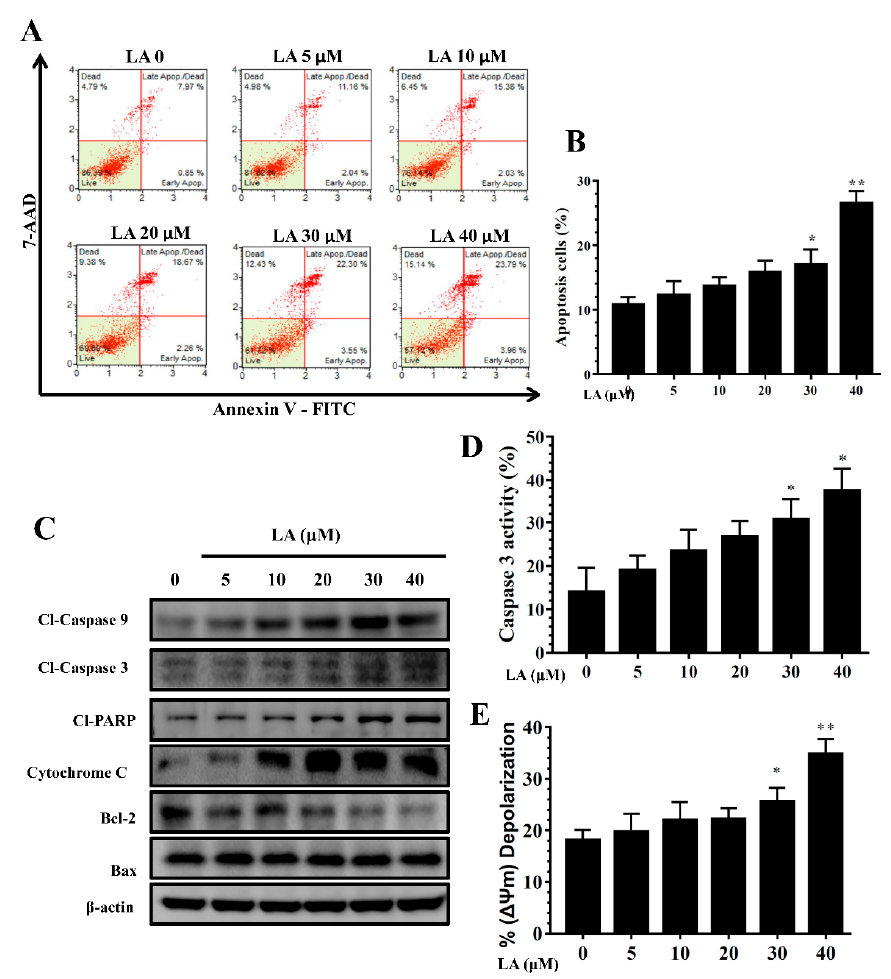
Figure 6. Licochalcone A (LA) regulated apoptosis in MDA-MB-231 cells. ( A ) Flow cytometry results showing that 24-h treatment with licochalcone A (LA) induced apoptosis in MDA-MB-231cells. ( B ) Percentage of apoptotic cells in each group. ( C ) Western blot of cleaved (cl) caspase-3, cleaved caspase-9, and cleaved PAPR-1, cytochrome c, Bal2, and Bax expression. β -actin levels were used as internal controls. ( D ) LA increased caspase-3 activity and ( E ) depolarized cells (i.e., decreased mitochondrial membrane potential) in MDA-MB-231 cells. The data are presented as mean ± SD of three